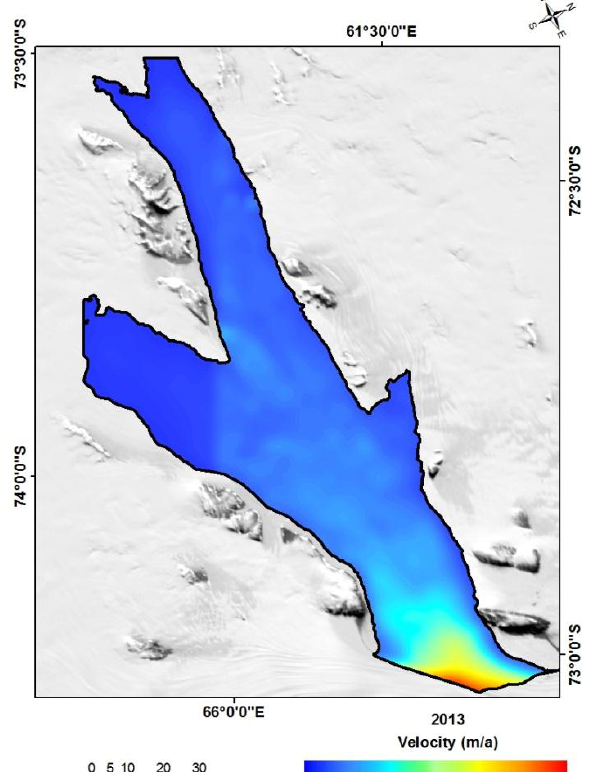
Figure 5: Estimated velocity of Fisher glacier in